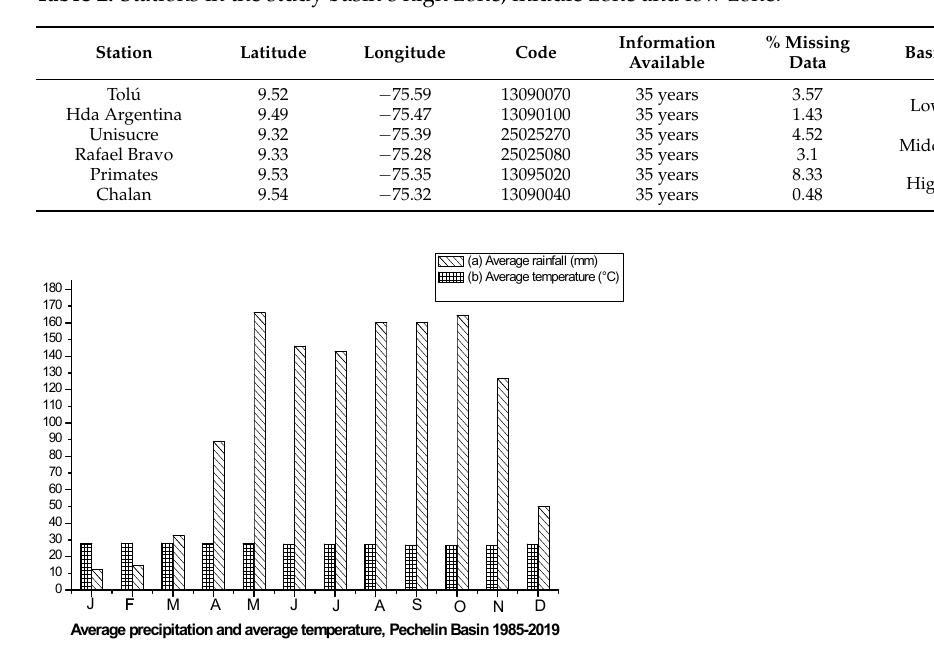
Figure 3. Average rainfall and average temperature, Pehelín basin 1985–2019: ( a ) average rainfall (mm); ( b ) average temperature (°C).